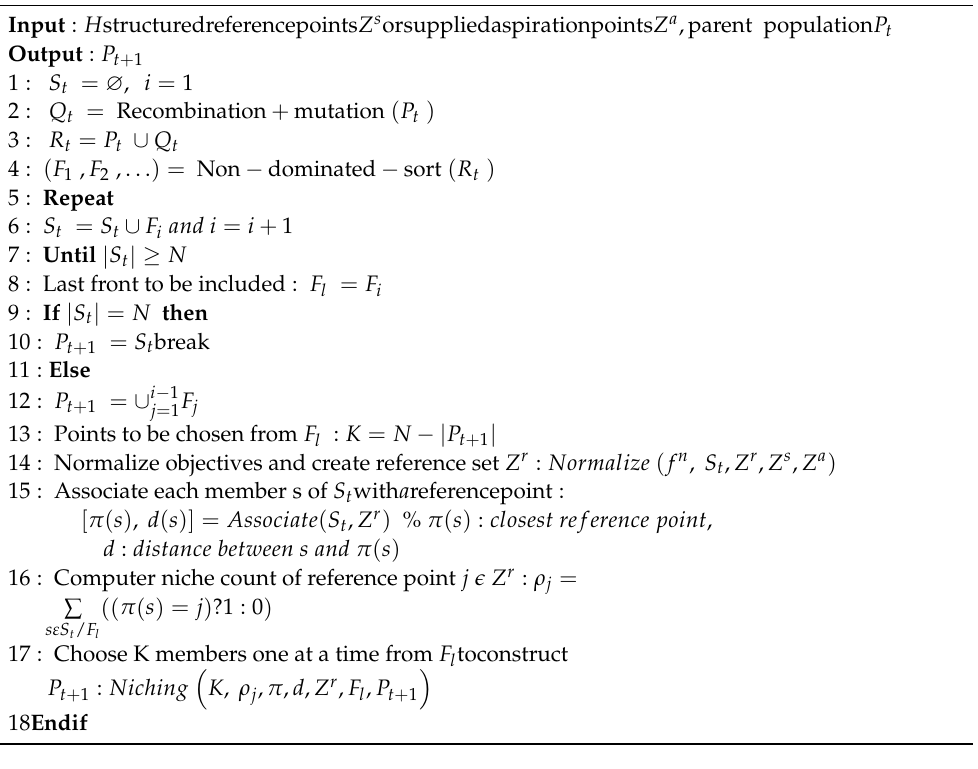
Algorithm 2 Generation t of NSGA-III procedure